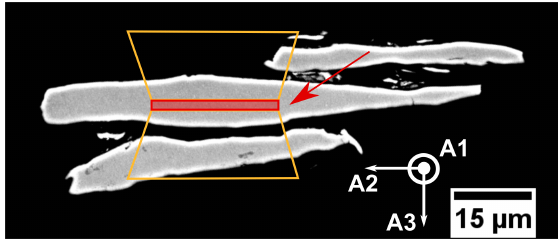
Figure 3. Cross-section view of powder particles with denoted cuts for the lamella preparation. Red—the lamella, orange—trenches for lamella lift-out. The axes A1–A3 correspond to the axes in pole figures in Figure 5.